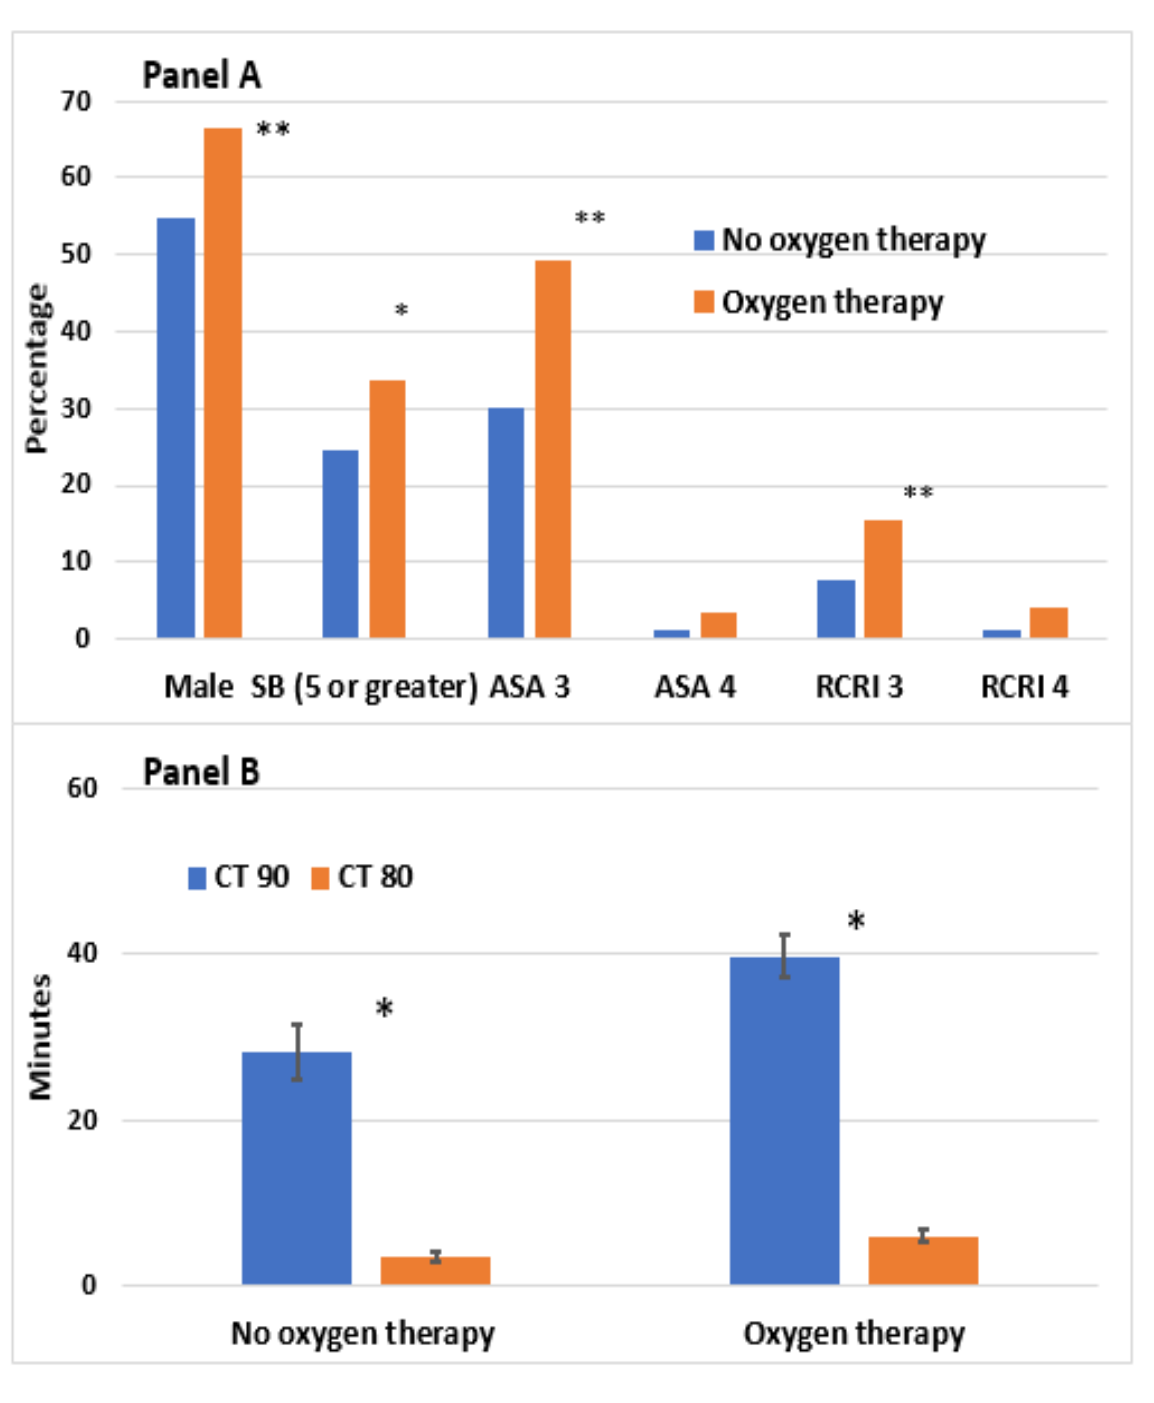
Figure 2. Characteristics of OSA patients receiving oxygen. Vertical bar represents the standard error of the mean. Panel ( A ) shows the demographic characteristics of patients receiving oxygen therapy. Panel ( B ) shows the oximetry parameters of patients receiving oxygen therapy. Abbreviations: SB: STOP-Bang score; RCRI: revised cardiac risk index; CT: cumulative time; SpO 2 : average